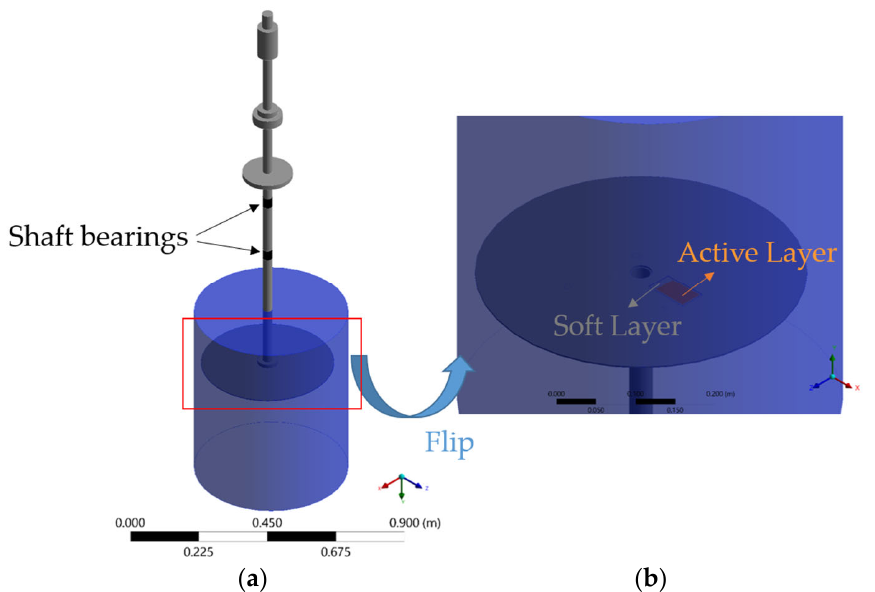
Figure 7. ( a ) Numerical model of the test rig when the disk was submerged inside the tank of water. ( b ) Close ‐ up around the piezoelectric patch model, with its active and soft layers indicated and the disk flipped to see the PZT in detail.